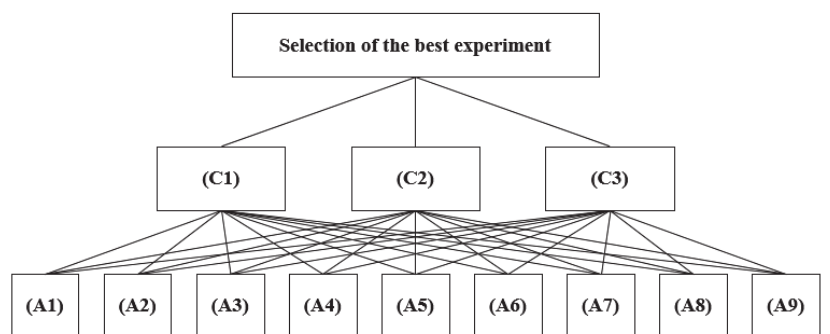
Fig. 4. The decision hierarchy of process parameters